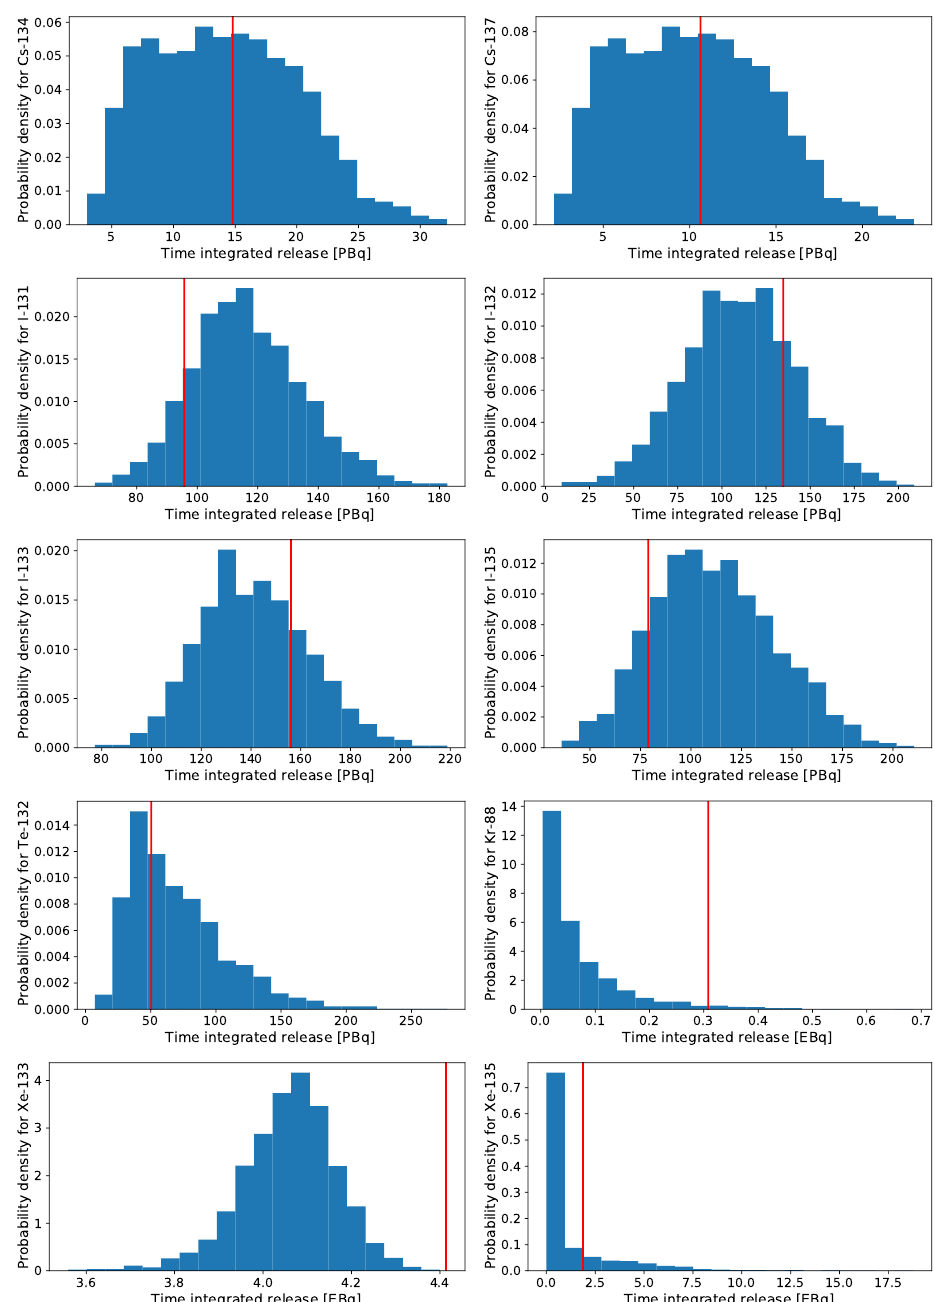
Figure 3. Probability density for each radionuclide as a function of time-integrated release. The vertical red lines show the actual released